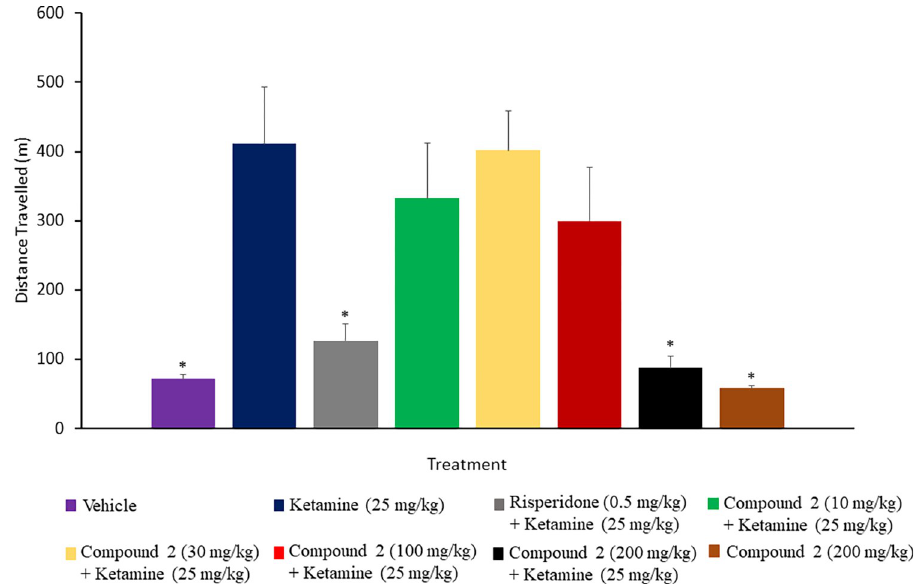
Fig 3. Effect of compound 2 on ketamine-induced hyperlocomotion in rats. Rats were pretreated with vehicle, risperidone or compound 2, 30 min before ketamine administration and then tested for locomotion activity. Rats treated with 200 mg/kg compound 2 showed a significant difference in locomotion activity compared to ketamine- treated rats. Data are expressed as a mean ± S.E.M (n = 8–12) and analysed by One-way ANOVA followed by Tukey’s post hoc test, � p < 0.05 compared to the schizophrenia control